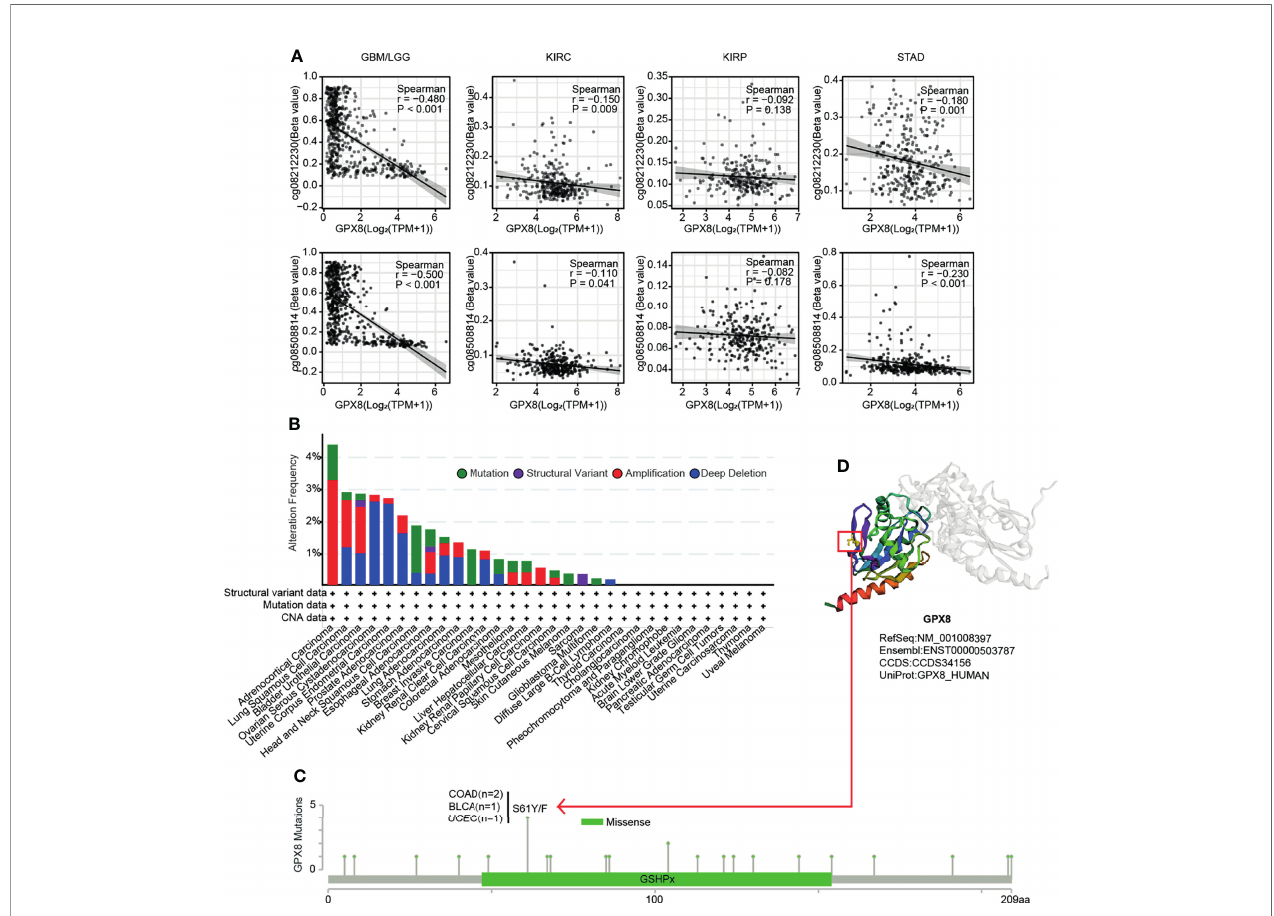
FIGURE 4 | DNA methylation analysis and Mutation feature of GPX8 in cancers. (A) DNA methylation of GPX8 in BM/LGG, KIRC, KIRP and STAD. (B) The alteration frequency and mutation type of GPX8. (https://www.cbioportal.org/). (C) The alteration frequency with mutation type and mutation site are displayed. (https://www. cbioportal.org/). (D) The mutation site with the highest alteration frequency (S61Y/F) in the 3D structure of GPX8.